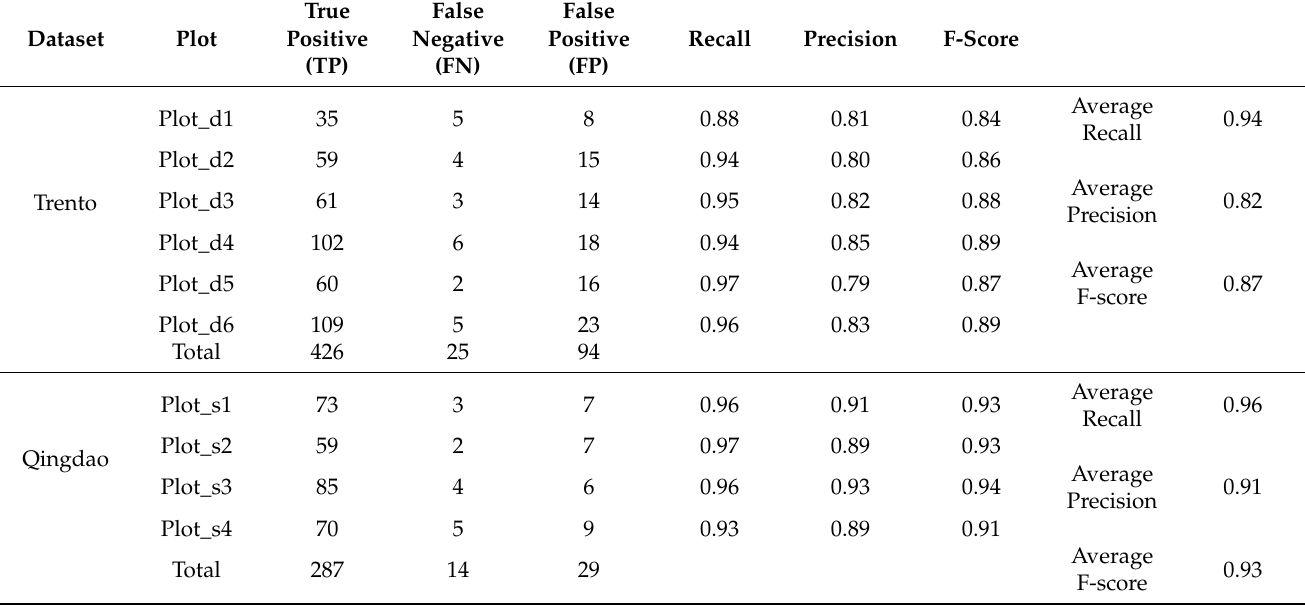
Table 4. MS+GMM-optimized segmentation results for the ten sample plots.